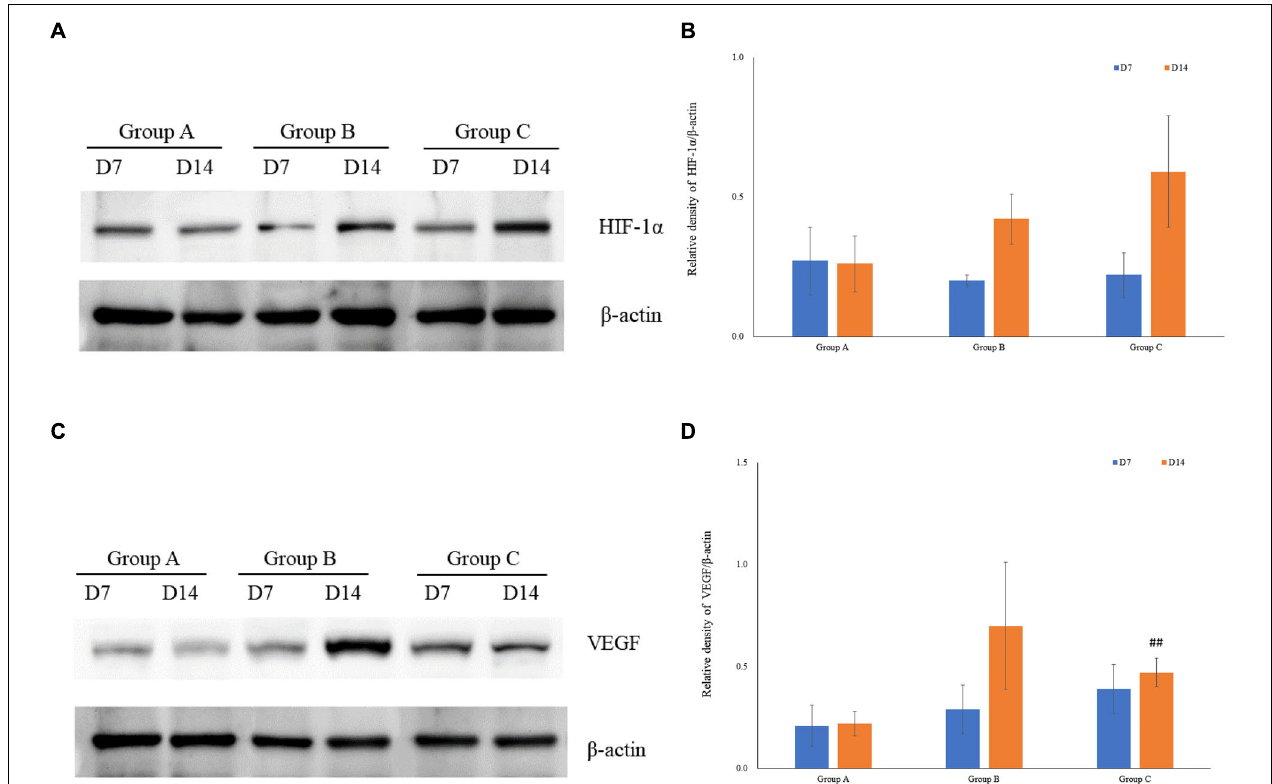
FIGURE 6 | The expression of HIF-1 α and VEGF measured by western blotting using rat kidney samples. (A) The expression of HIF-1 α in rat kidneys. (B) Quantitative analysis of HIF-1 α by western blotting using rat kidney samples (C) The expression of VEGF in rat kidneys. (D) Quantitative analysis of VEGF in rats’ kidneys by western blotting. ## P < 0.05 vs. group